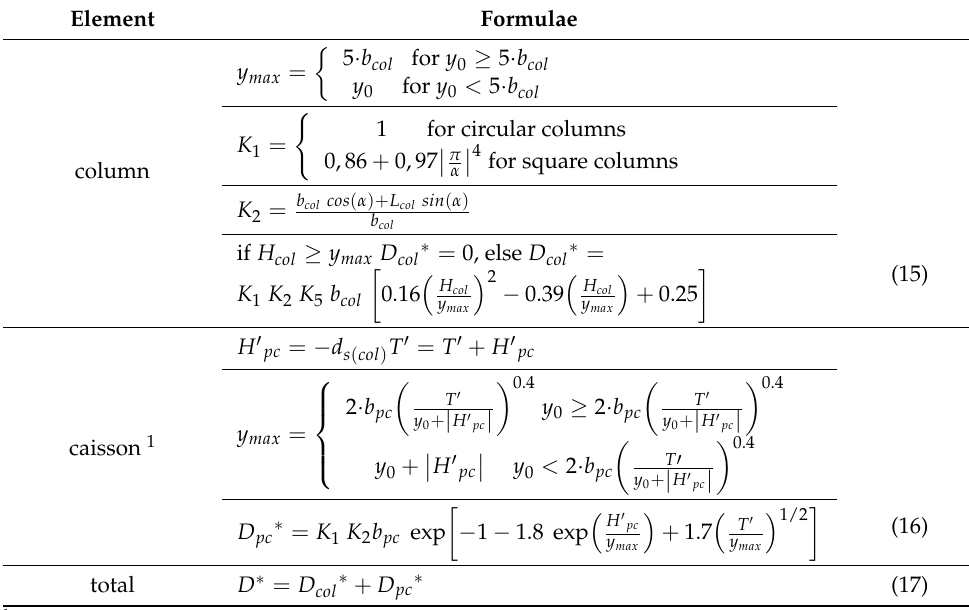
Table 4. Procedure for calculating effective width of complex piers for estimating scour